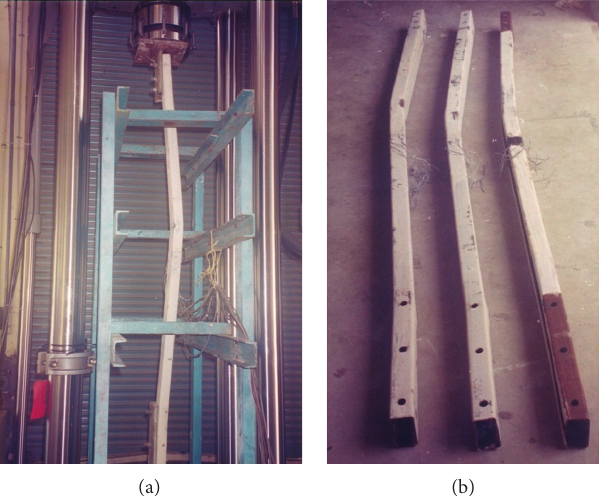
Figure 4: Test details of compression tests carried out in this investigation. (a) Test set-up (b) Tested specimens.